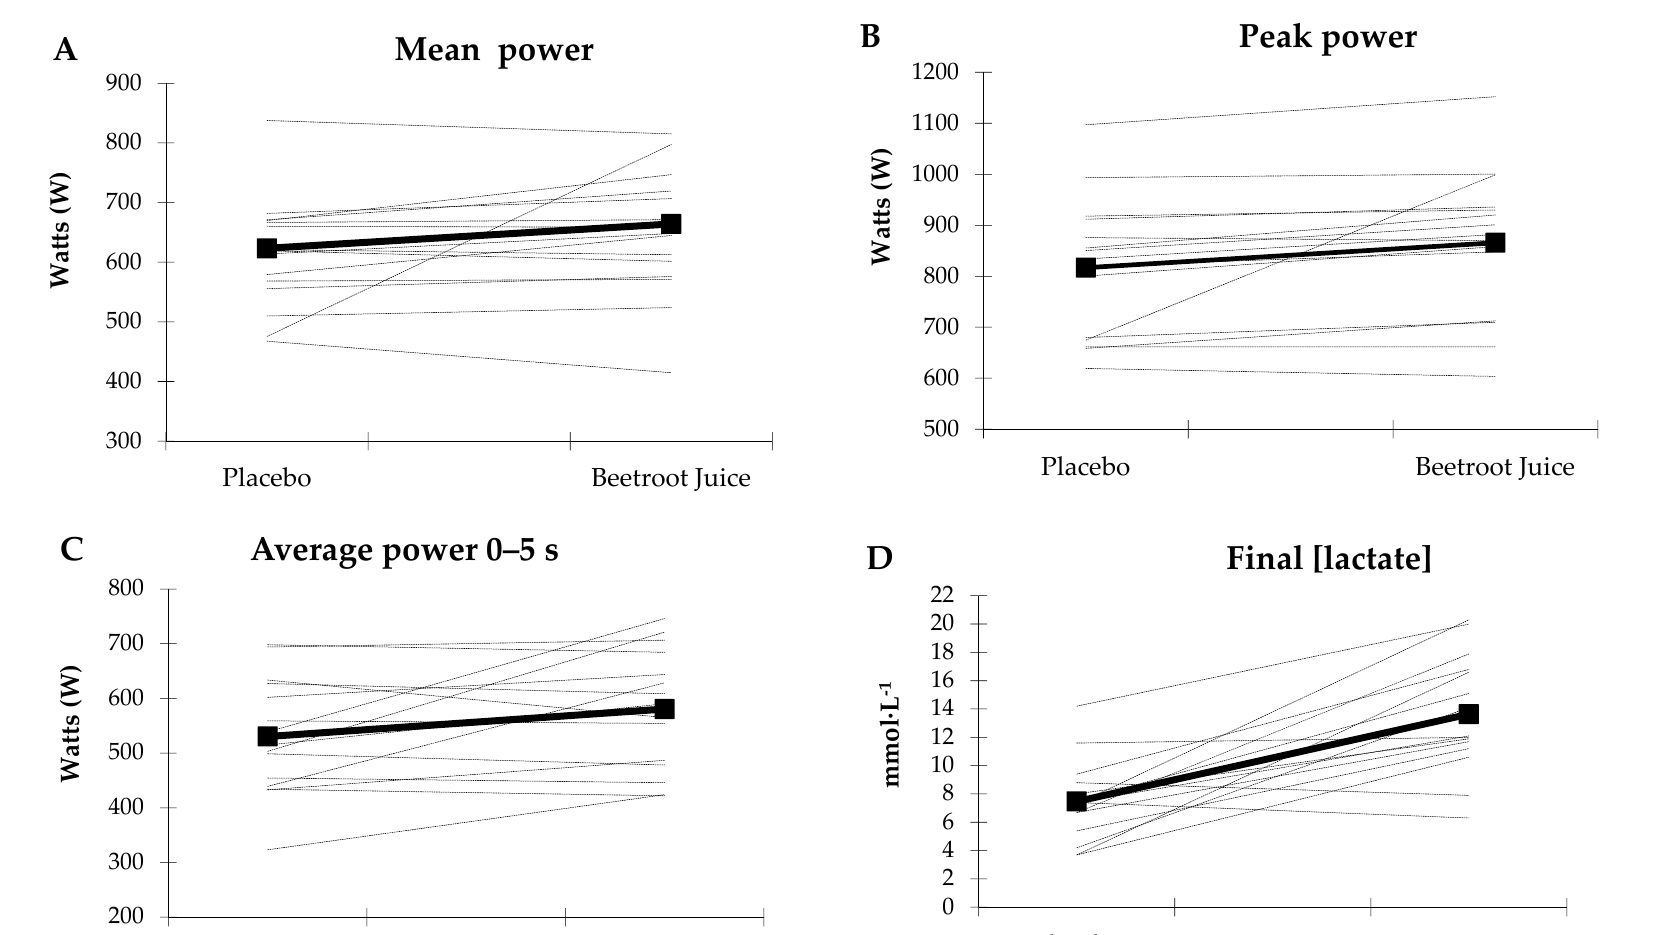
Figure 4. Mean power ( A ); peak power ( B ); average power 0–5 s ( C ) and Final (lactate) ( D ) recorded in all participants (dashed line) and average for the sample (continuous line).